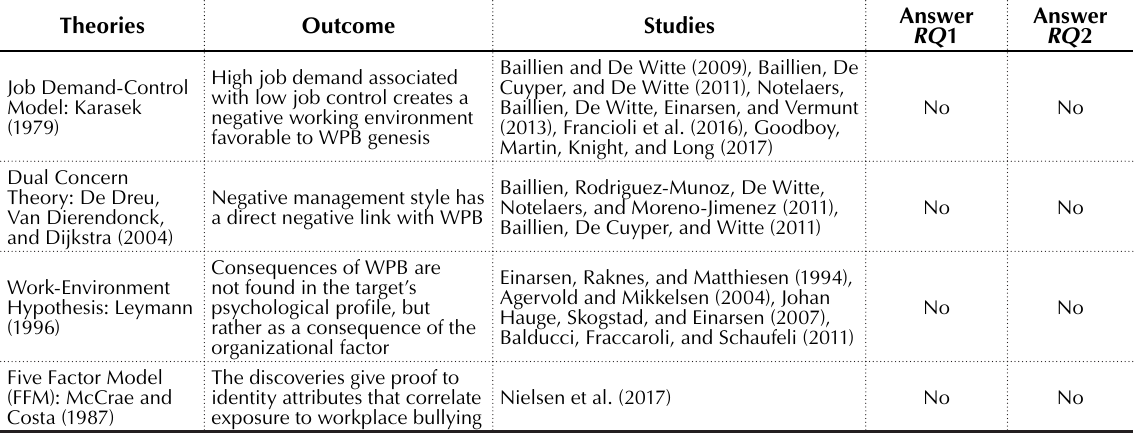
Table 1. Theories of WPB: the four Antecedent-Bullying Relationship theories